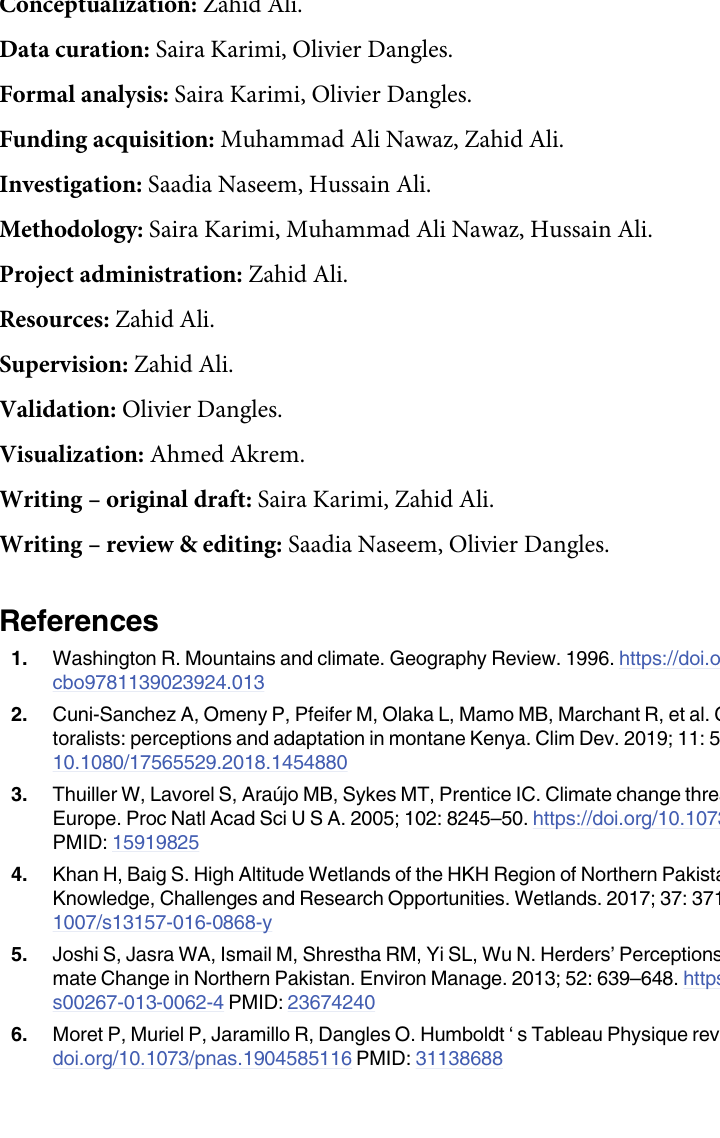
S4 Table. Summary from fitting a linear mixed-effects model by restricted maximum like- lihood, to predict species-specific response to each treatment. Significance. codes: 0 ‘ ��� ’